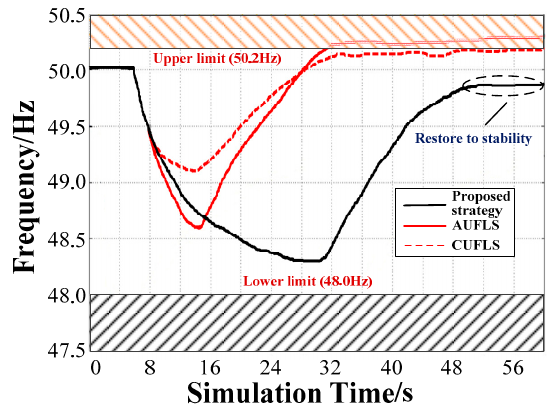
Figure 8. The frequency recovery process of each strategy under scenario-3.